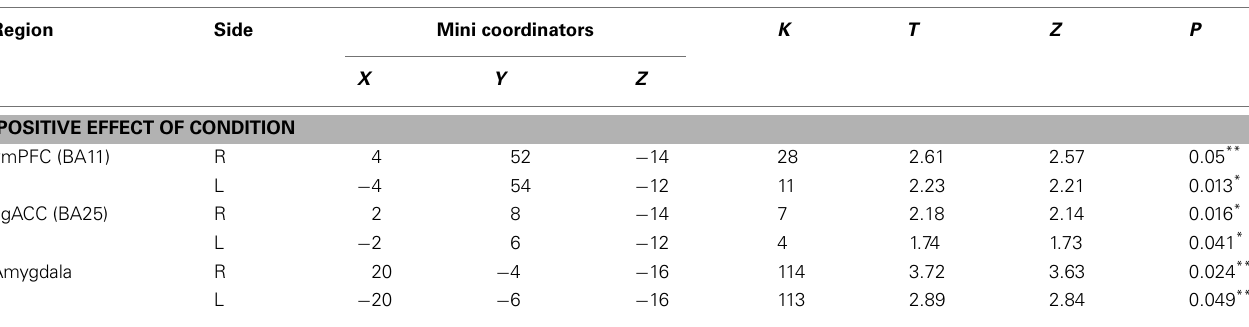
Table 3 |Amygdala, vmPFC, and sgACC activity during the dynamic faces task.